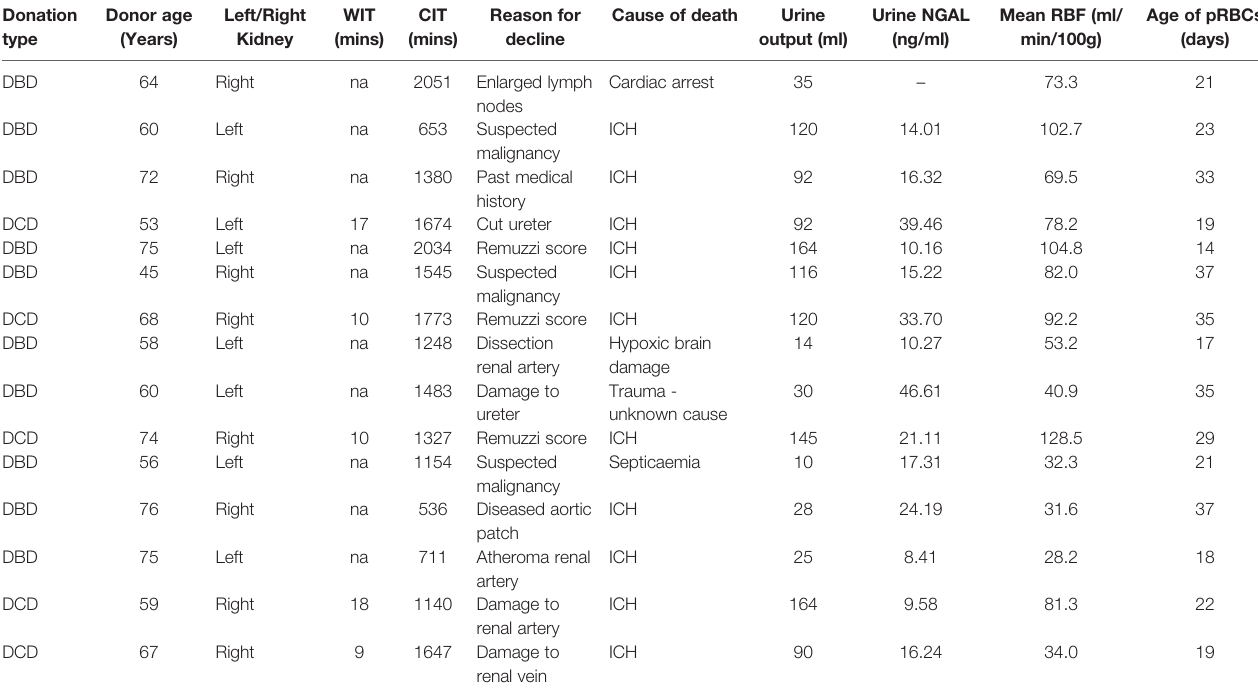
TABLE 2 | Donor demographics and ischemic times for research kidneys (n=15) that underwent 1h